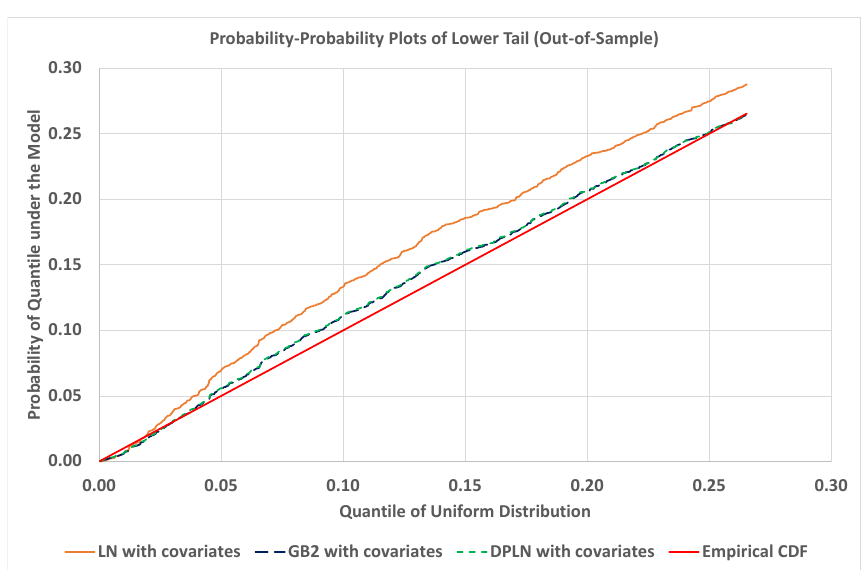
Figure 4. Probability-probability plot of lower tail